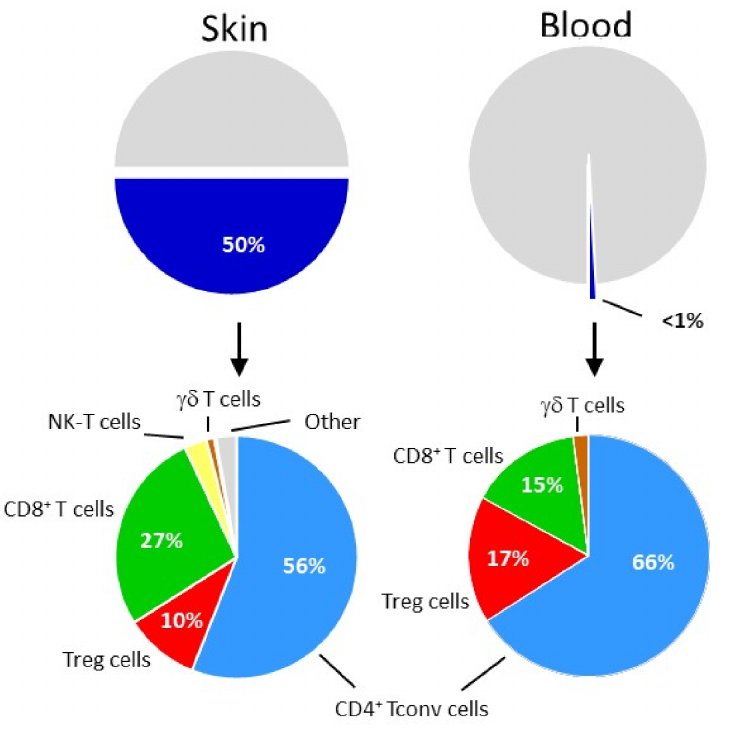
Figure 3. Human skin is the principal site of CCR8-expressing lymphocytes and NK cells. Protein expression analyses demonstrate a predominance of CCR8 + cells among lymphocytes, amounting to 50% of all immune cells present in human skin. Of these, CD4 + and CD8 + conventional αβ T cells and Treg cells make up >90%. CCR8 + immune cells are rare in peripheral blood and share the subset diversity with human skin CCR8 + immune cells (except for NK cells). Numbers represent fractions of CCR8 + cells expressed as the mean percentage of total lymphoid cells (T and B cells, ILCs) out of n = 3–12 independent experiments with skin tissue or blood samples from >20 individual donors ([77–79] and unpublished studies).